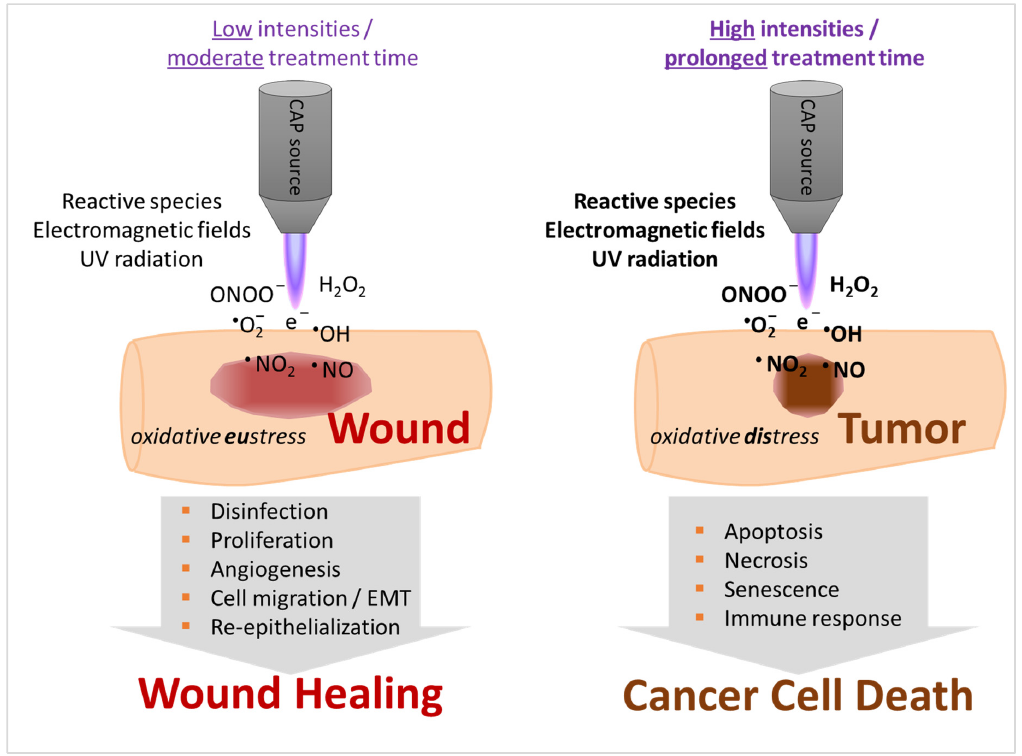
Figure 1. Cold atmospheric pressure plasma (CAP) in wound and cancer treatment. Wound healing, disinfection, and tissue regeneration are triggered by short or moderate CAP treatment (left panel). It is hypothesized that ultraviolet (UV) radiation, electromagnetic fields, and/or reactive oxygen and nitrogen species acting either alone or in concert contribute to the effects observed. Prolonged treatment for cancer therapy enhances oxidative stress from eustress to distress and hence will induce cancer cell death (right panel). EMT = epithelial-mesenchymal transition.